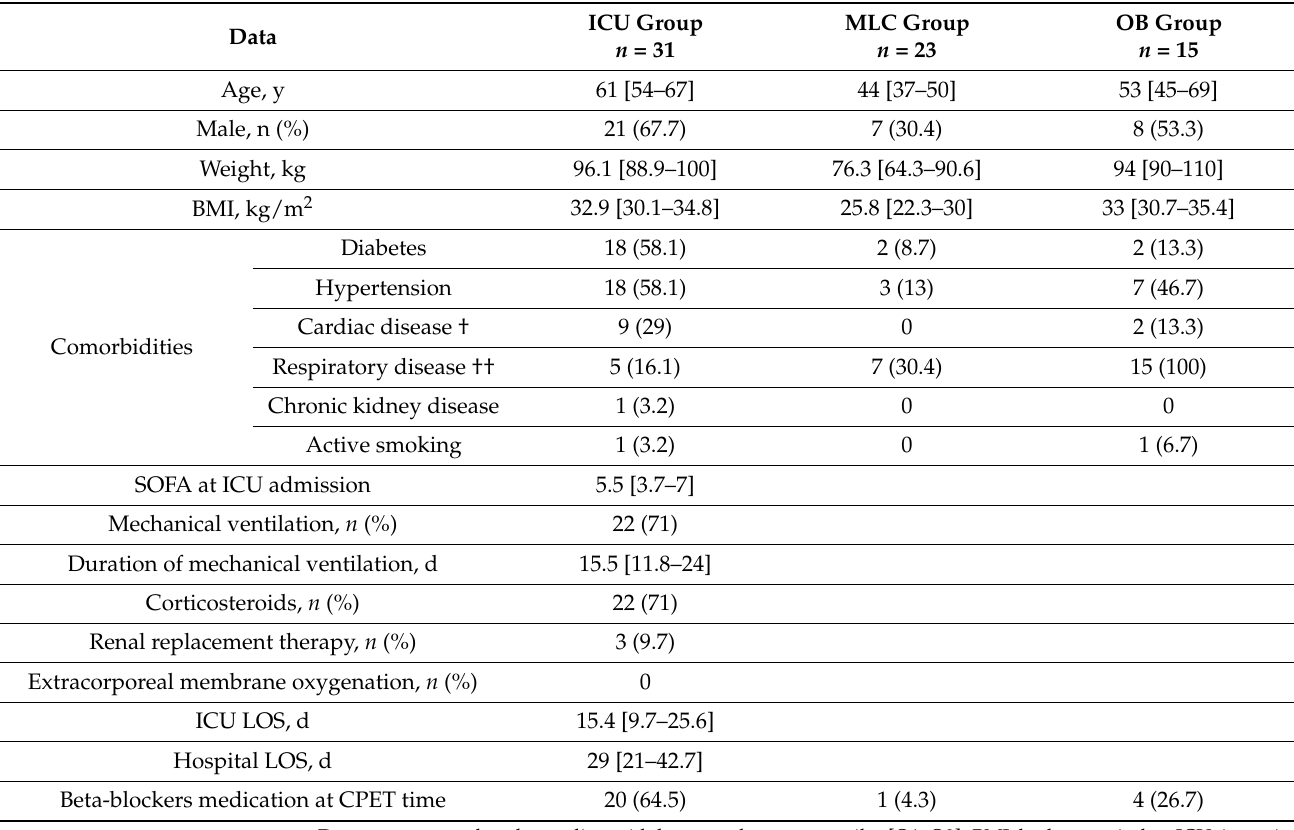
Table 1. Characteristics of the three groups of patients.